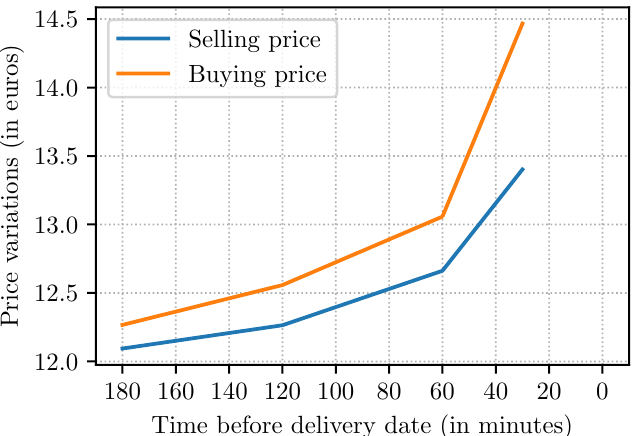
Figure 6. Price variations in euros as a function of time before delivery date. Blue line in for the selling price on intraday and orange line is for the buying